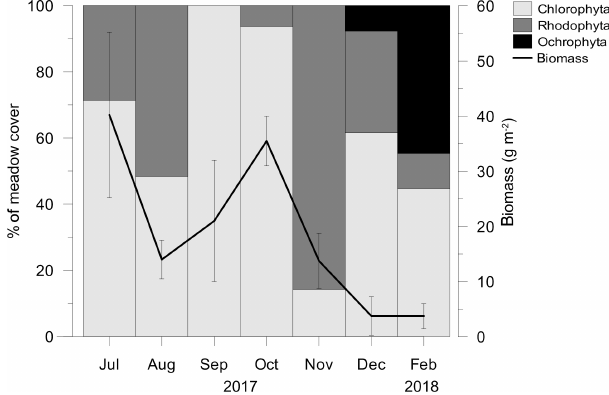
Figure 4. The contribution of macroalgal phyla in a meadow cover and total macroalgal biomass. After February 2018 macroalgae were no longer present in the C. nodosa